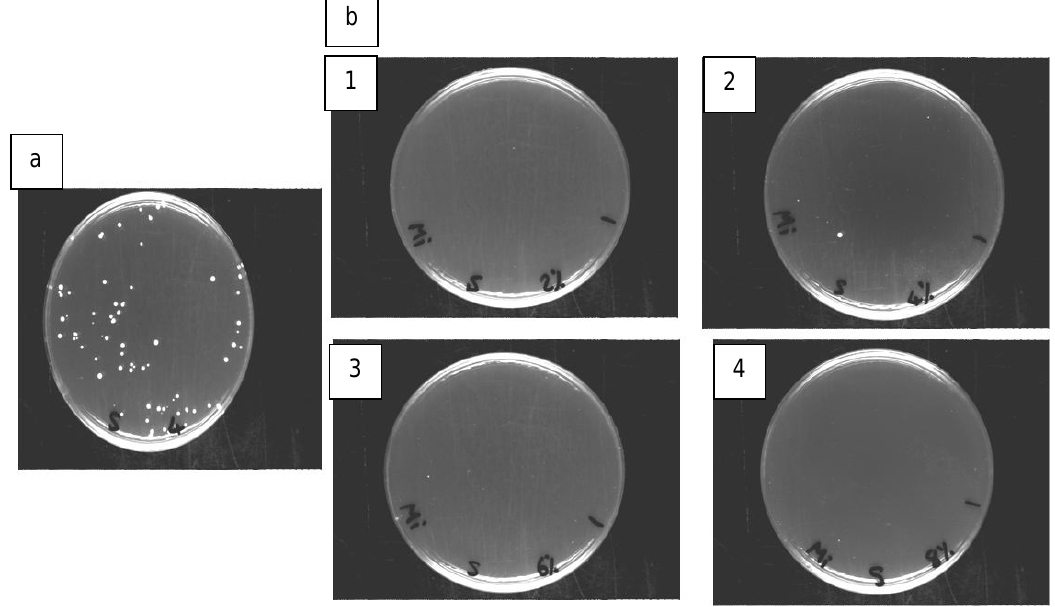
Fig. 8. Antibacterial activity of AgNP@EPR composites against S. aureus (a) blank without composite (b) in present of composites (1) 2 vol% (2) 4 vol% (3) 6 vol% (4) 8 vol%